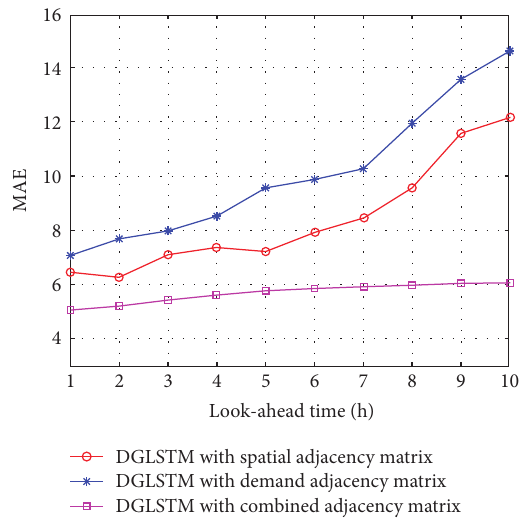
Figure 11: Influence of the adjacency matrix on the prediction model.